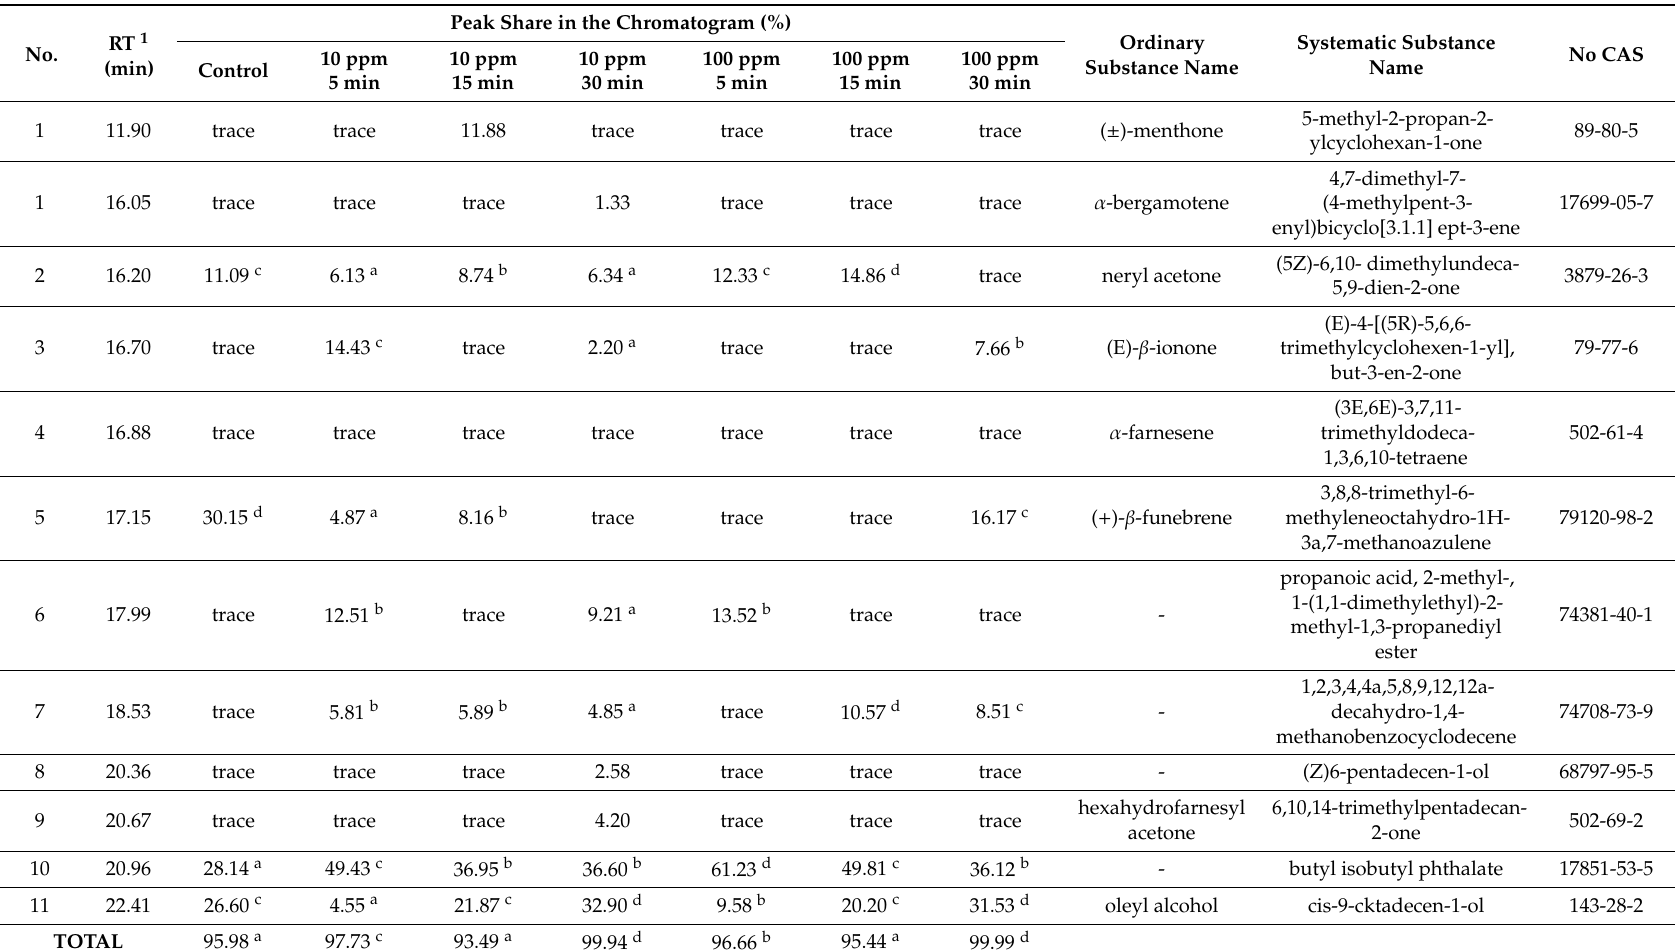
Table 1. Chemical composition of headspace fractions of rhubarb